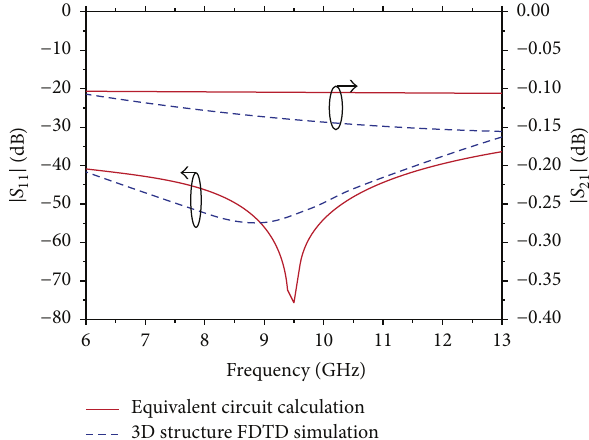
Figure 9: Contrast between the equivalent circuit calculation and 3D structure FDTD simulation.